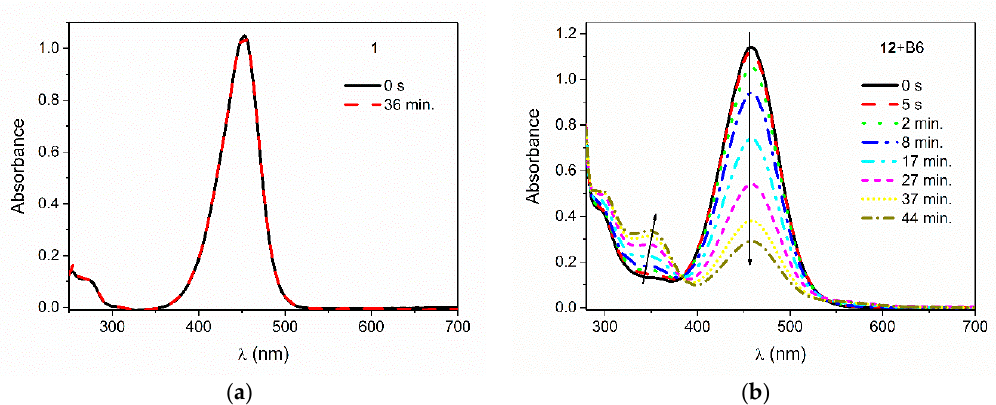
Figure 3. Electronic absorption spectra obtained upon irradiation of a system comprising an air-saturated solution of ( a ) dye 1 (1.5 × 10 − 5 M) and ( b ) dye 12 (3 × 10 − 5 M) in the presence of B6 (3 × 10 − 3 M) dissolved in the mixture ethyl acetate: 1-methyl-2-pyrrolidone (20:4, v / v ). Spectra were collected before and after laser irradiation (line 457 nm, I 0 = 50